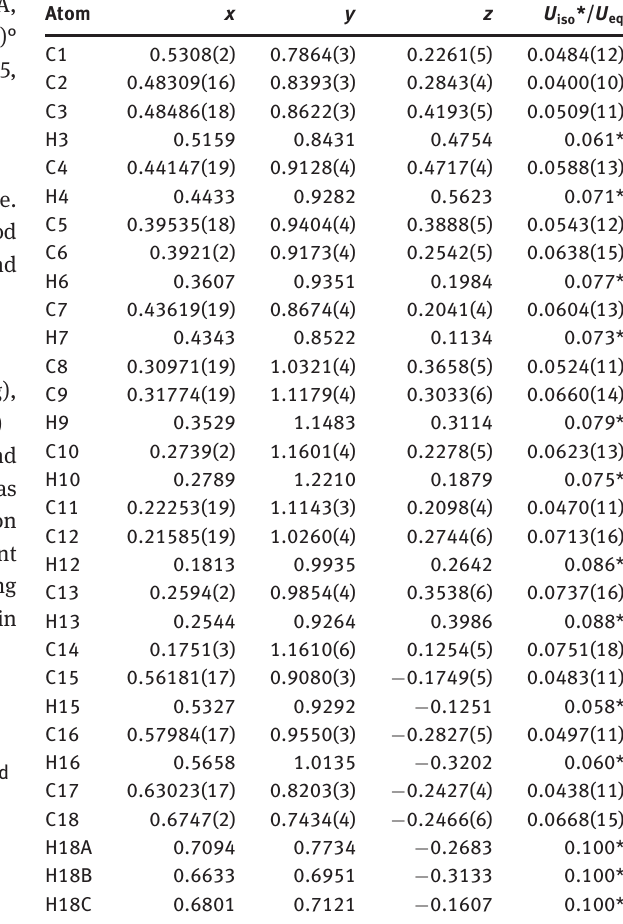
Table 2: Fractional atomic coordinates and isotropic or equivalent isotropic displacement parameters (Å 2